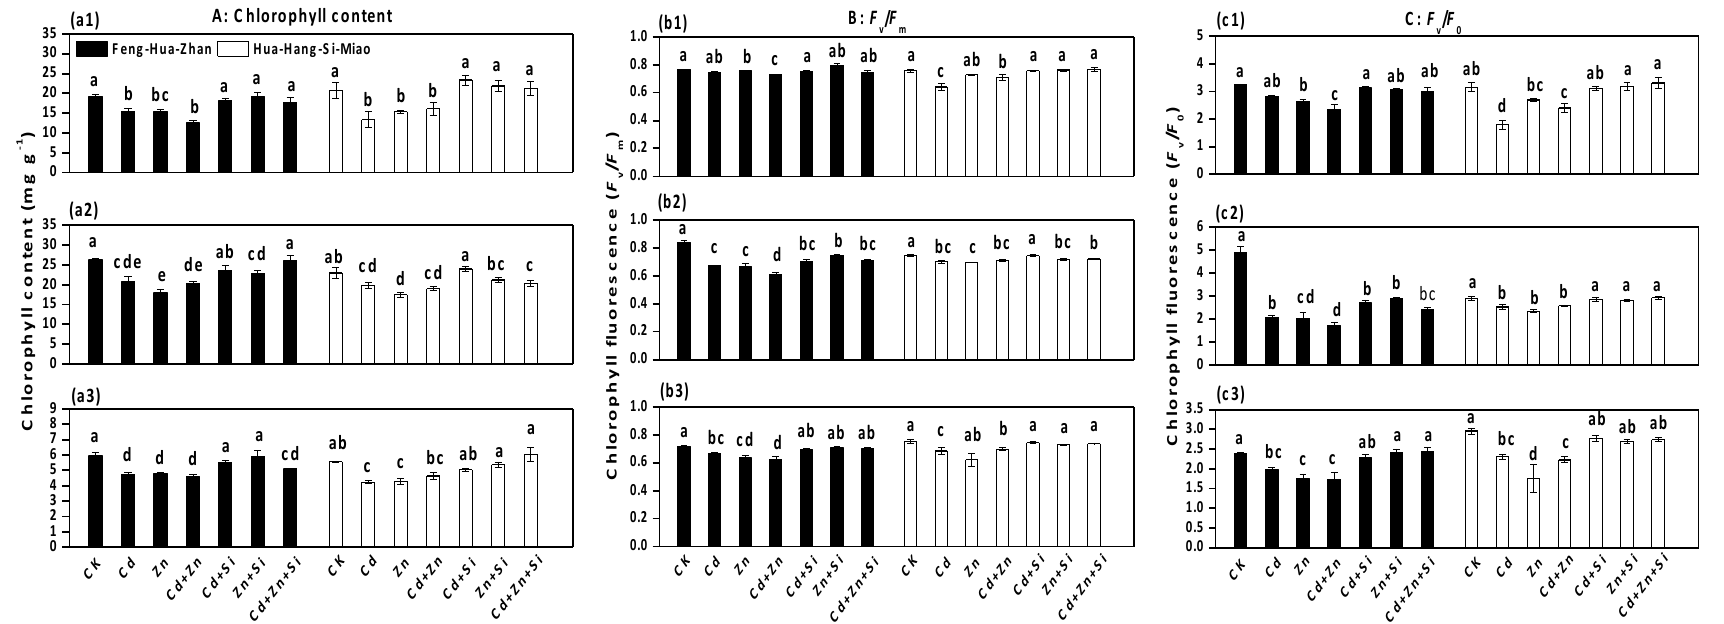
Figure+5. "Effect"of"Si"on"the"total"chlorophyll"content"and"the"chlorophyll"fluorescence"parameter"in"two"rice"cultivars"in"different"growth"stages:"( a1 ),"( b1 )"and"( c1 )"seedling"stage;" Figure 5. Effect of Si on the total chlorophyll content and the chlorophyll fluorescence parameter in two rice cultivars in different growth stages: ( a1 ), ( b1 ) and ( c1 ) ( a2 ),"( b2 )"and"( c2 )"tillering"stage;"( a3 ),"( b3 )"and"( c3 )"ripening"stage."Error"bars"indicate"standard"deviations"( n "="4)."Bars"with"different"letters"are"significantly"different"( p% <"0.05)" seedling stage; ( a2 ), ( b2 ) and ( c2 ) tillering stage; ( a3 ), ( b3 ) and ( c3 ) ripening stage. Error bars indicate standard deviations ( n = 4). Bars with different letters are according"to"Duncan’s"MRT." significantly different ( p < 0.05) according to Duncan’s